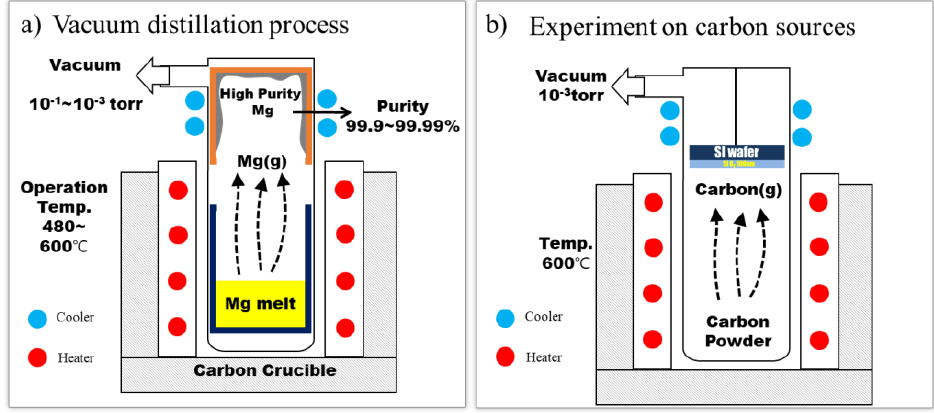
Figure 7. Schematic of the vacuum distillation process ( a ) and the experiment on carbon sources generation ( b ).